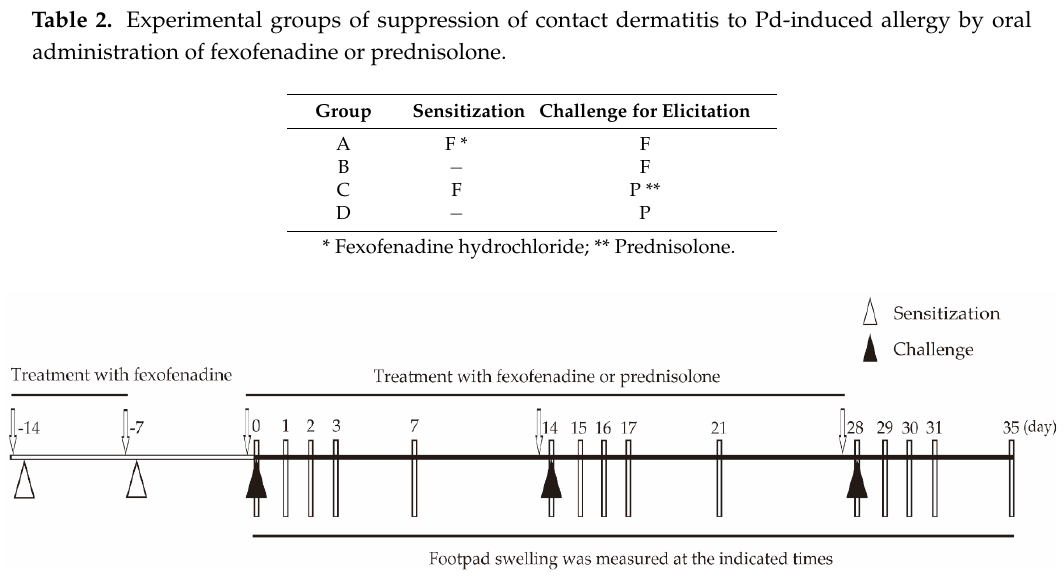
Table 2. Experimental groups of suppression of contact dermatitis to Pd-induced allergy by oral administration of fexofenadine or prednisolone.